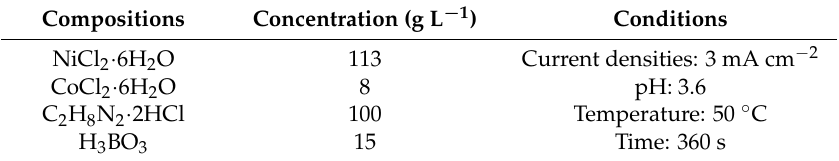
Table 1. Bath compositions and operating conditions for electrodeposition of